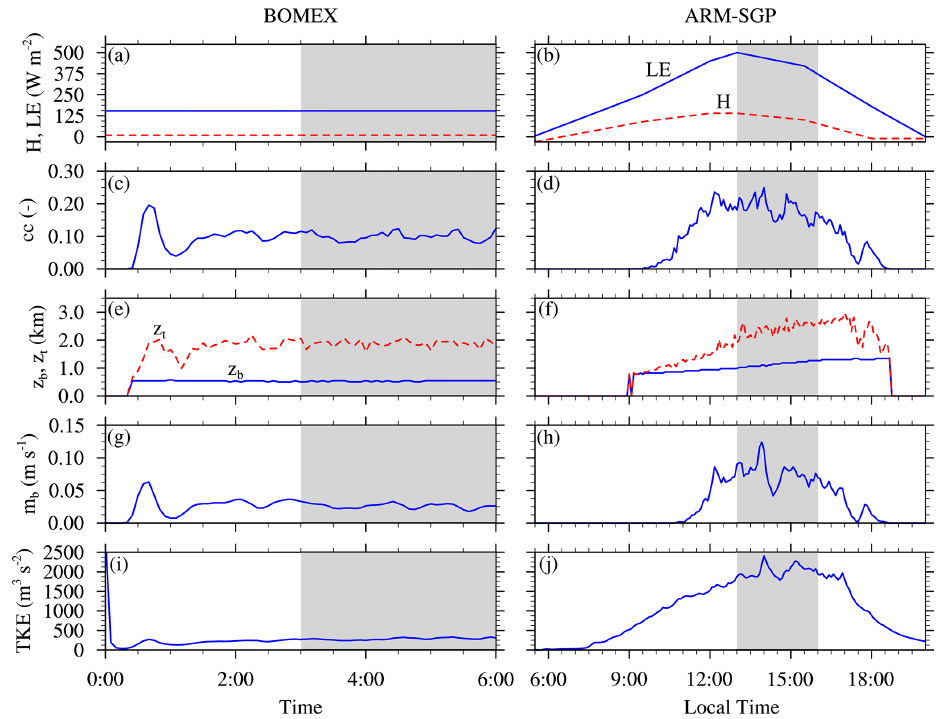
Figure 1. Time series of (a–b) latent and sensible heat fluxes, (c–d) total cloud cover, (e–f) cloud-base and cloud-top height, (g–h) cloud- core base mass flux, and (i–j) vertically integrated TKE. The first column shows the time series for the BOMEX CTRL simulations, and the second column depicts the temporal evolution of the ARM-SGP CTRL. The gray shading indicates the time window over which averages have been